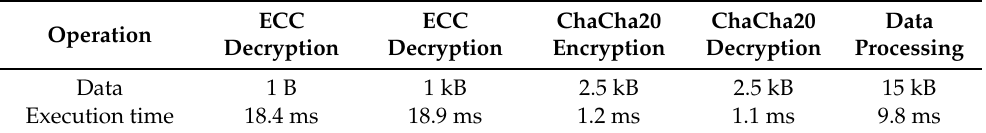
Table 2. OM execution broken in individual operations; the operation execution time was mea- sured on the ESP32-DevKitC V4. Cryptographic operations were carried out using the Libsodium library [57]. The public-key cipher is ECC based using Curve25519 [58] and the symmetric key cipher is ChaCha20.